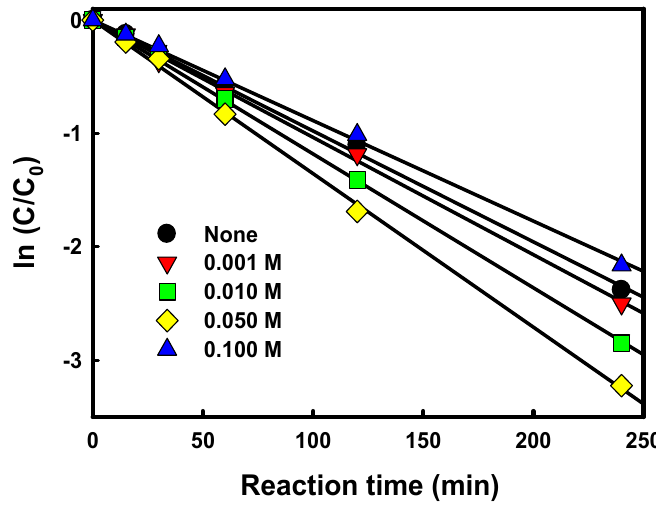
Figure 2. Degradation rate of ASA measured at various hydrogen peroxide addition amounts.